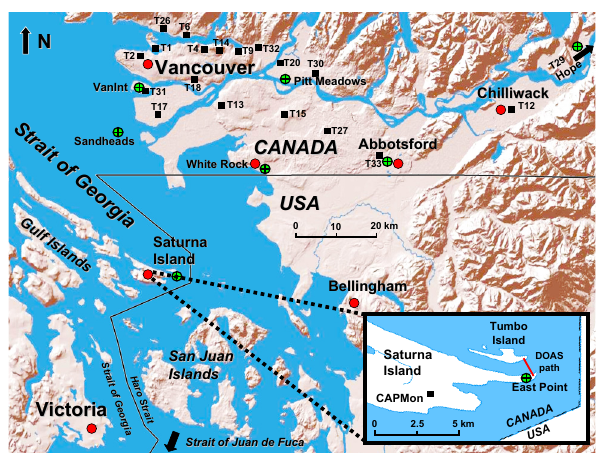
Fig. 1. Map of the Lower Fraser Valley and surrounding marine areas. Solid squares indicate Greater Vancouver Regional District air quality monitoring stations. Circles with cross indicate Environ- ment Canada climate stations. The inset shows the measurement site at East Point, Saturna